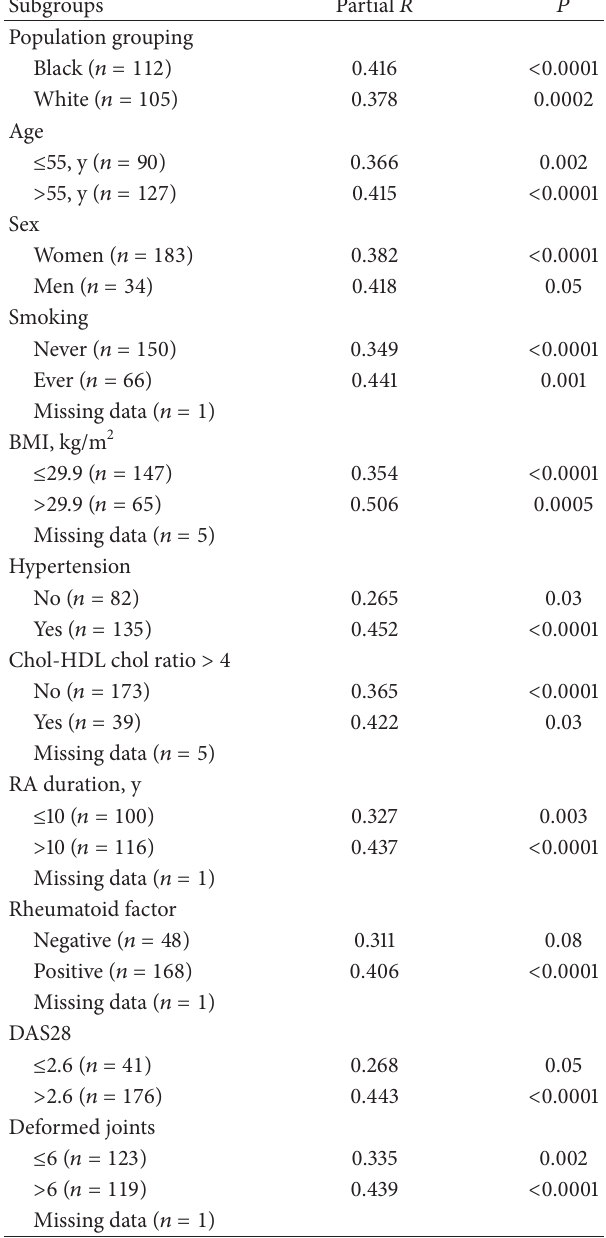
Age, sex, and cardiovascular risk factors were adjusted in each model as in Table 2. BMI: body mass index; HDL: high-density lipoprotein; RA: rheumatoidarthritis;DAS28:diseaseactivityscorein28joints(valuesof ≤ 2.6 and > 2.6 indicate the presence of disease remission or mild disease activity and moderate or high disease activity, resp.).